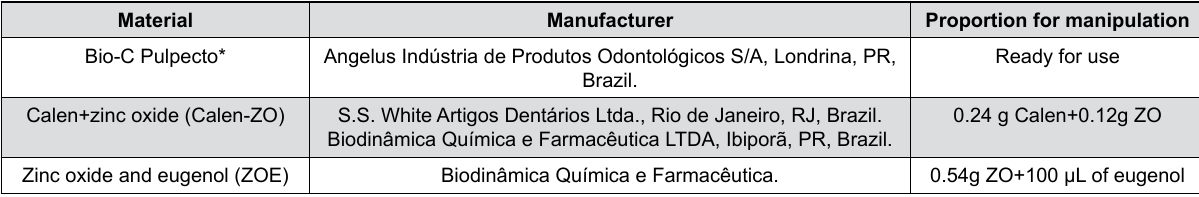
Figure 1- Root canal filling material, manufacturer and proportion of use. * Product under development, batch no.